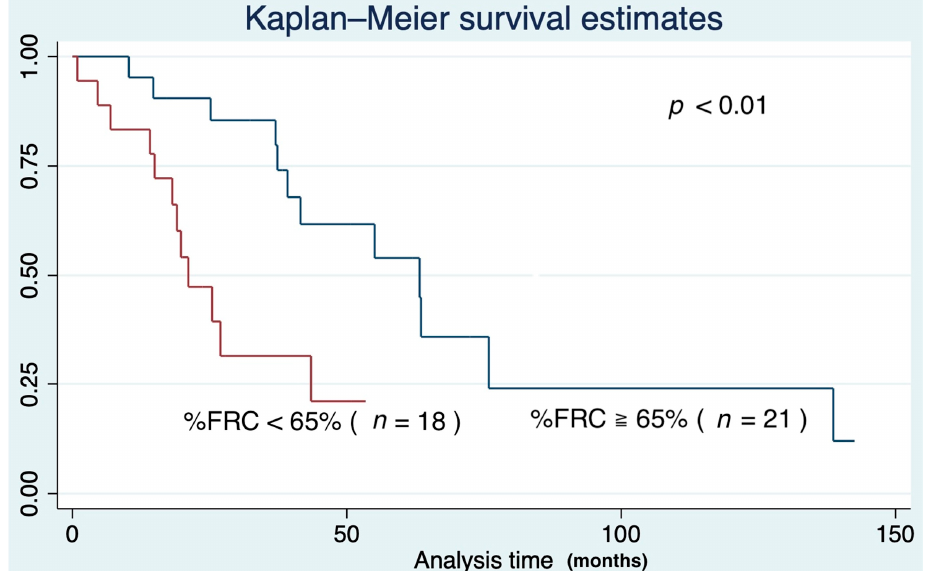
Figure 6. Kaplan–Meier survival curve according to the %functional residual capacity.